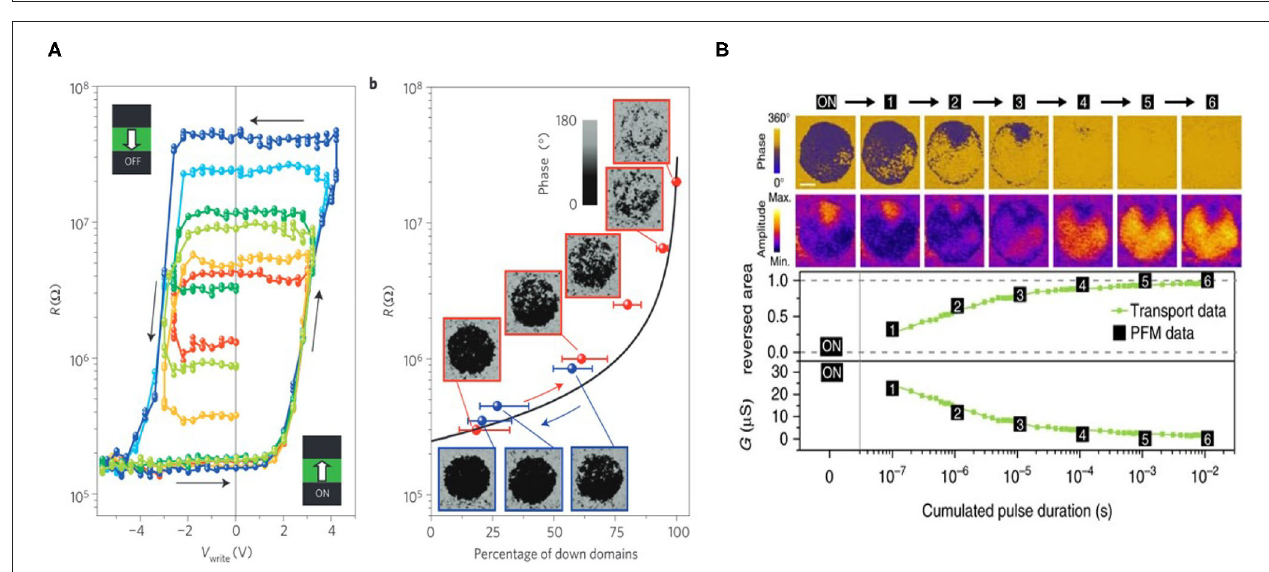
FIGURE 9 | (A) Multi-level state characterized by tunneling electro-resistance of a FTJ comprising BaTiO 3 as the tunnel barrier sandwiched between Au/Co and LSMO electrodes. The resistance states are found to follow the percentage of domains switched by applied voltages. Figure reproduced with permission from Chanthbouala et al. Nat. Mater. 11, 860–864 (2012). Copyright 2012 Springer Nature. (B) Gradual conductance change of a BaFeO 3 based FTJ under accumulated pulses is experimentally observed to be closely associated with the switching process of ferroelectric multi-domains. The behavior of conductance change under pulses can be directly implemented into neuromorphic functionalities such as synaptic plasticity. Figure reproduced from Boyn et al. Nat. Commun. 8, 14736 (2017). Copyright 2017, Authors, licensed under a Creative Commons Attribution (CC BY) license.